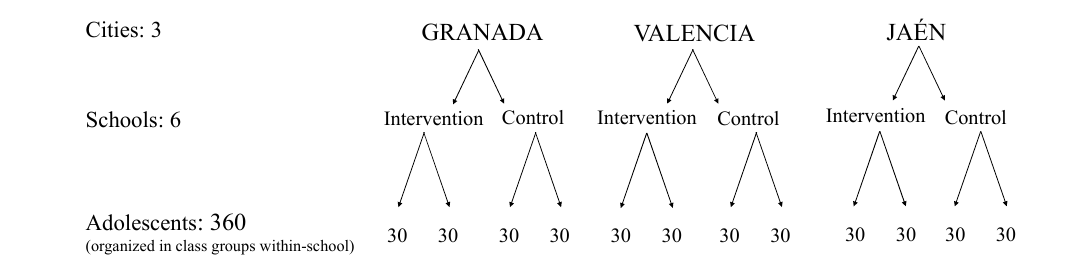
Figure 2. Cities, schools, and adolescent participants in the PACO study.